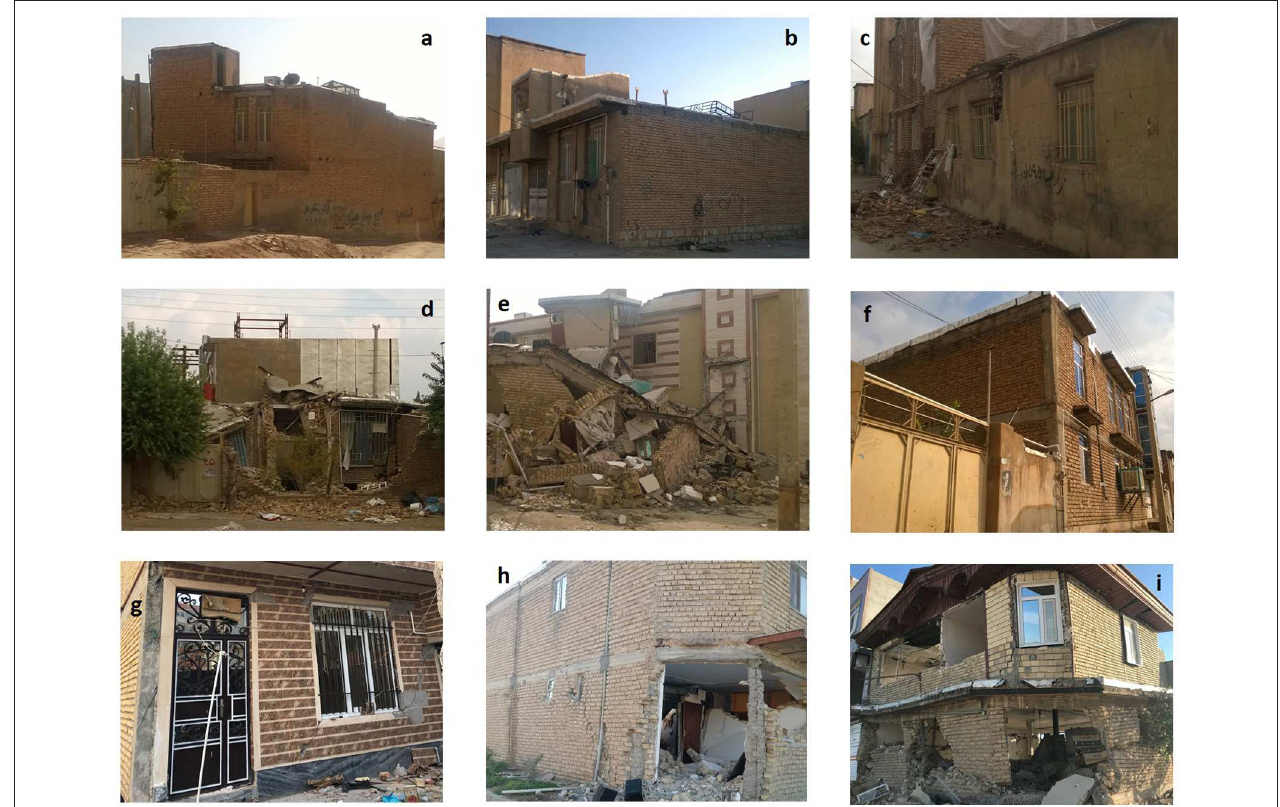
FIGURE 1 | Damaged Sarpol-e-zahab masonry building samples (a) URM D1, (b) URM D2, (c) URM D3, (d) URM D4, (e) URM D5, (f) CM D1, (g) CM D2, (h) CM D3, and (i) CM D4